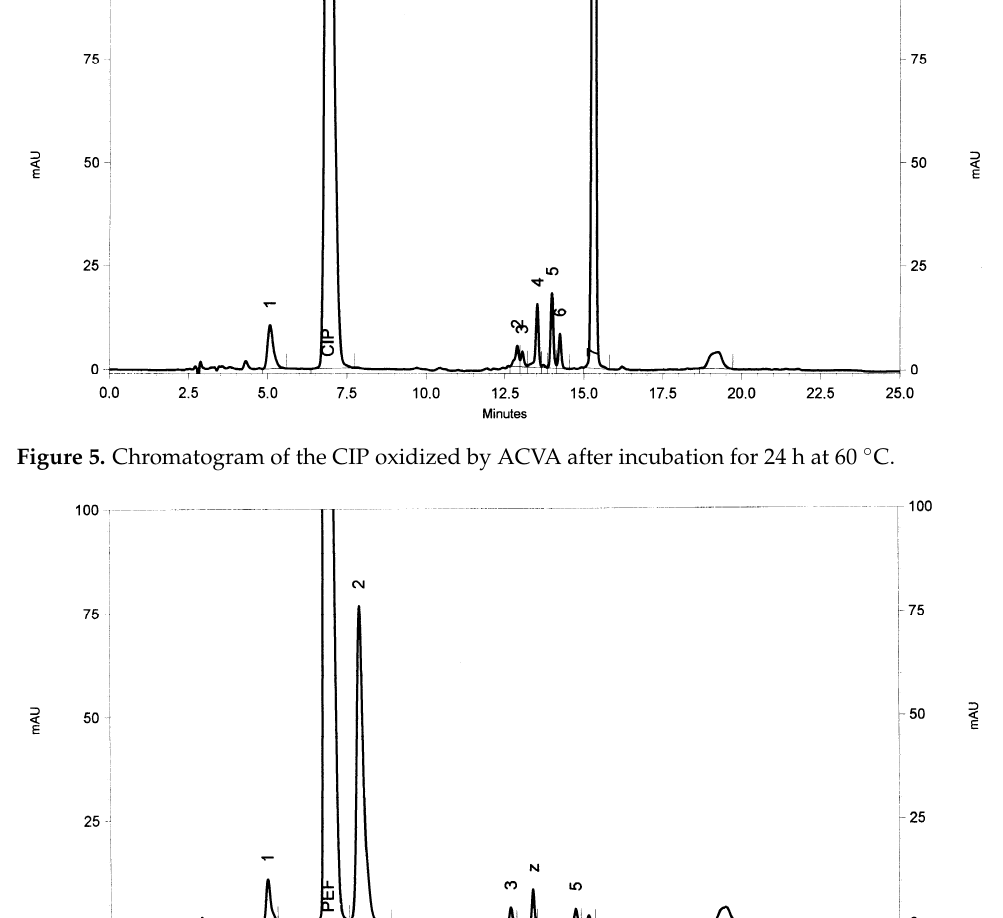
Figure 6. Chromatogram of the PEF oxidized by ACVA after incubation for 336 h at 40 °C.